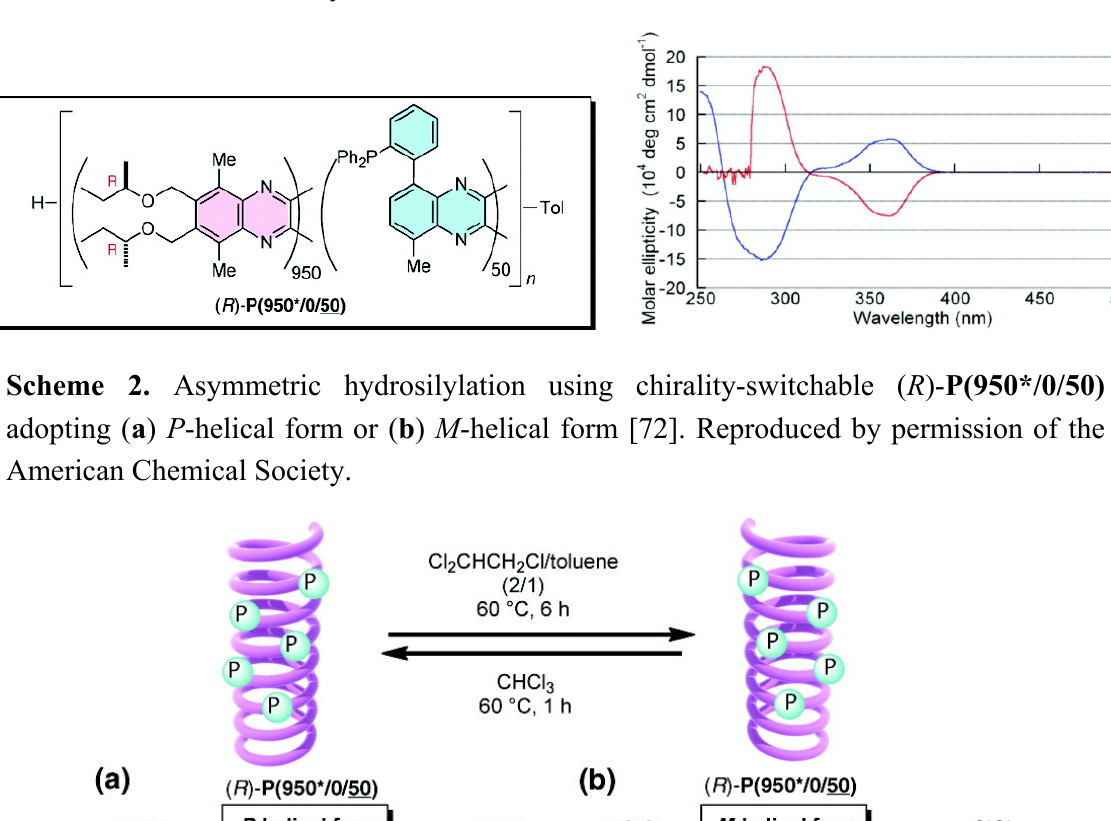
Figure 16. CD spectra of ( R )- P(950*/0/50) in chloroform (blue line) and in a 1,1,2- trichloroethane/toluene (2/1) mixture (red line) [72]. Reproduced by permission of